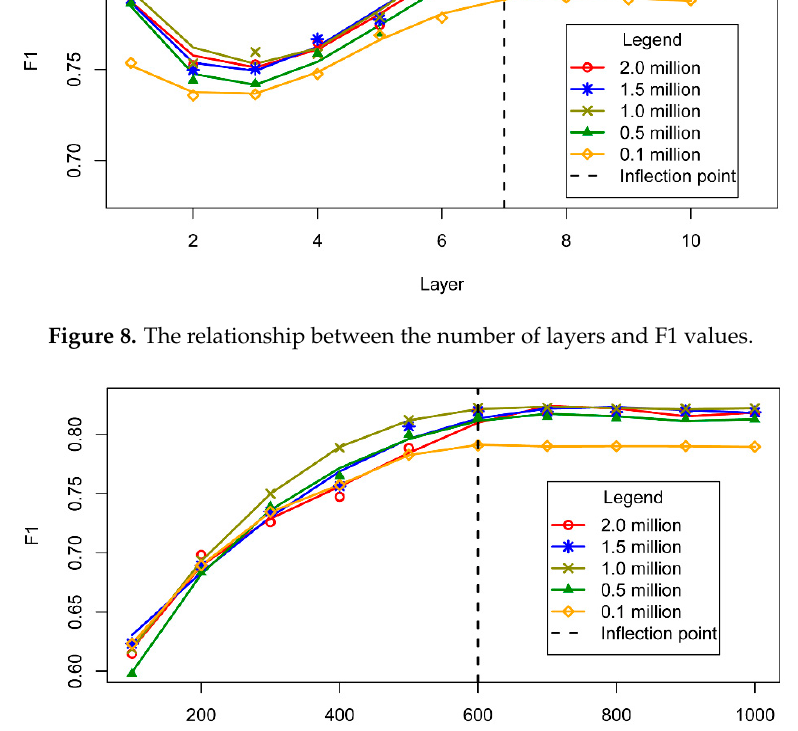
Figure 9. The relationship between the number of nodes in each layer and F1 values.